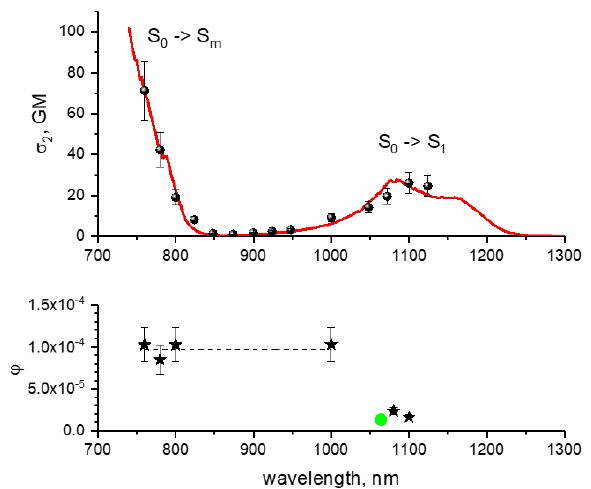
Figure 2. Top : Two-photon absorption spectrum of mCherry in purified buffer solution at pH8, (red line) [11] and two-photon excitation spectrum of mCherry measured in E. coli cells (symbols) (normalized to the 2PA cross section of solution spectrum at 760 nm). Bottom : Quantum yield of the first step of photobleaching process initiated by absorption of two photons as a function of excitation wavelength (black asterisks) for mCherry in E. coli . Quantum yield of the first step of one-photon induced photobleaching process upon laser excitation at 532 nm [36] is shown by a green circle at double wavelength (1064 nm).